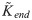
Reformulation of stiffness equations.Obtaining Eq 10 requires that we transform the matrices in Eq 7. In this way, the vector K˜end can be expressed as a set of linear equations in a→. These linear equations become the linear constraints for endpoint stiffness that we use to solve the quadratic programming problem to minimize energy. (•) denotes element-by-element multiplication, and Ri is the ith row of R.